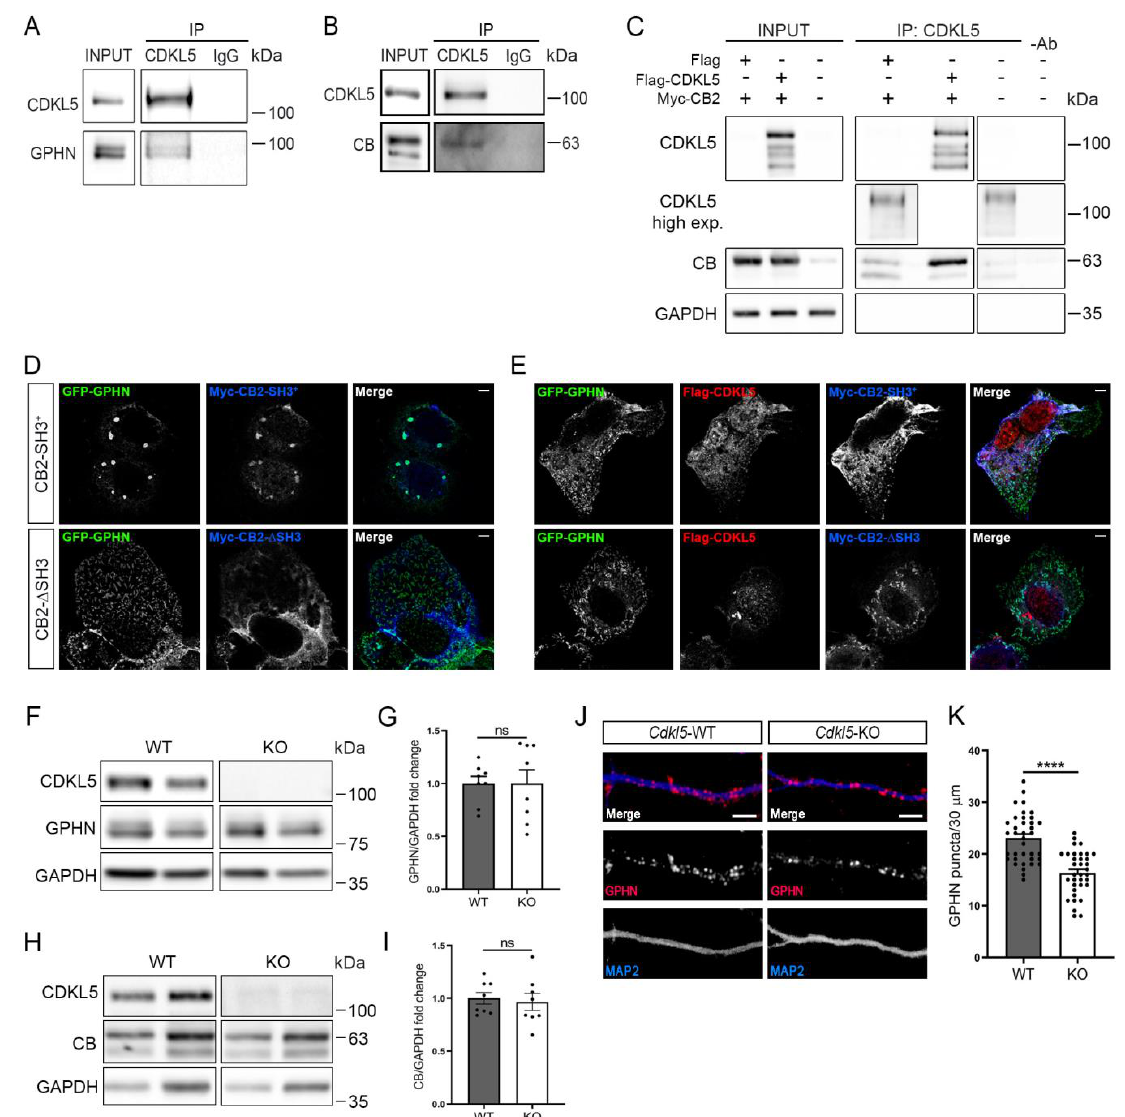
Figure 1. CDKL5 interacts with the gephyrin-collybistin complex. ( A , B ) Representative WBs showing the coimmuniprecipitation of CDKL5 and gephyrin (GPHN; A) or collybistin (CB; B) from PND20-30 mouse brain lysates. Unrelated IgGs were used as negative control. Whole brain lysate (input; 2.5%) and immunocomplexes were analysed through WB with antibodies against CDKL5, GPHN ( A ) and CB ( B ). n = 3. ( C ) Flag-CDKL5 was expressed in HEK293T cells together with Myc-CB2 and immunoprecipitated with a monoclonal anti-CDKL5 antibody. Whole cell lysates (input; 3%) and immunoprecipitated proteins were analysed through WB using antibodies against CDKL5, CB and, as loading control, GAPDH. n = 3. ( D , E ) Representative confocal images of COS7 cells expressing GFP- tagged gephyrin (GFP-GPHN, green) and Myc-CB2-SH3 + or Myc-CB2- ∆ SH3 (blue) together with Flag-CDKL5 (red). Scale bar: 5 µ m. ( F , H ) Representative WB of whole cell lysates of Cdkl5 -WT/KO primary hippocampal neurons at DIV14. Antibodies against GPHN and CB were used together with anti-CDKL5 and, as loading control, GAPDH. ( G , I ) The graphs show the quantification of normalised GPHN ( G ) and CB ( I ) levels. n = 8 biological replicates. Mean ± SEM. Not significant (ns), p > 0.05. Unpaired Student’s t -test. ( J ) Representative images of DIV14 Cdkl5 -WT/KO hippocampal neurons stained with antibodies against GPHN (red) and the dendritic marker MAP2 (blue). Scale bar, 5 µ m. ( K ) Graph showing the quantification of GPHN puncta along 30 µ m long segments. n = 7 biological replicates, N = 37/35 WT/KO neurons. Mean ± SEM. **** p < 0.0001. Unpaired Student’s t